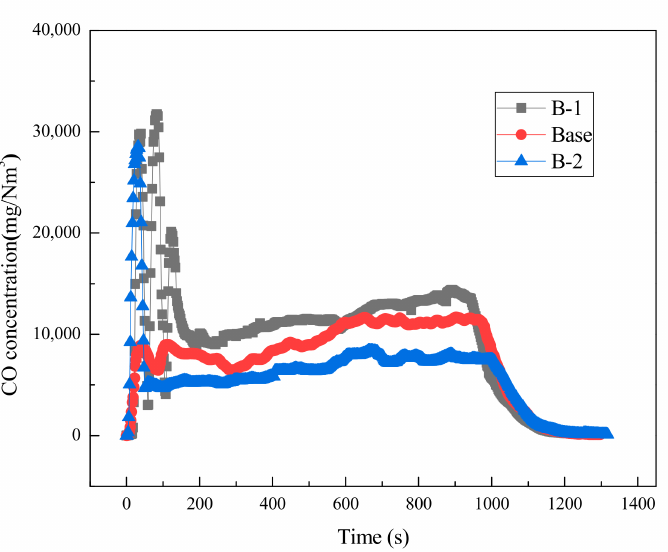
Figure 5. CO emission concentration during sintering at various ratios of CTC. (The ratios of CTC: B-1 = 1.8; Base = 2.0; B-2 =